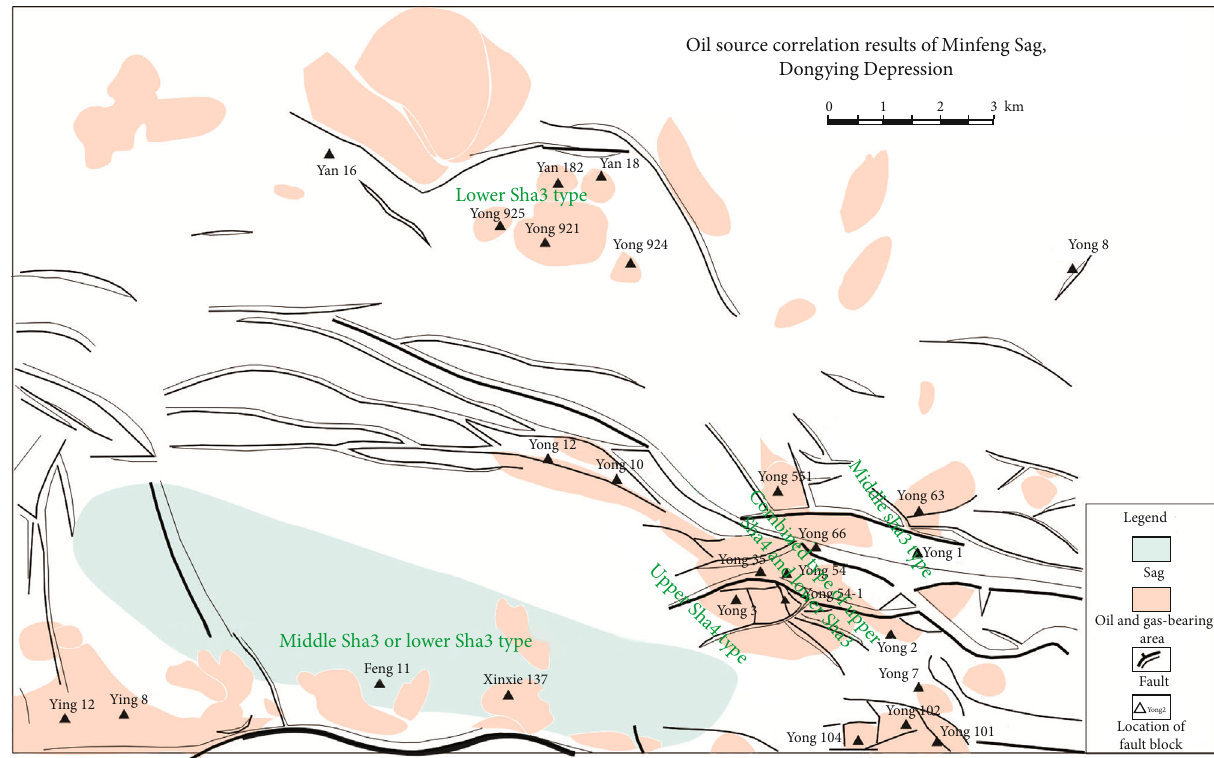
Figure 7: Oil source correlation results and hydrocarbon migration direction of the Minfeng Sag, Dongying